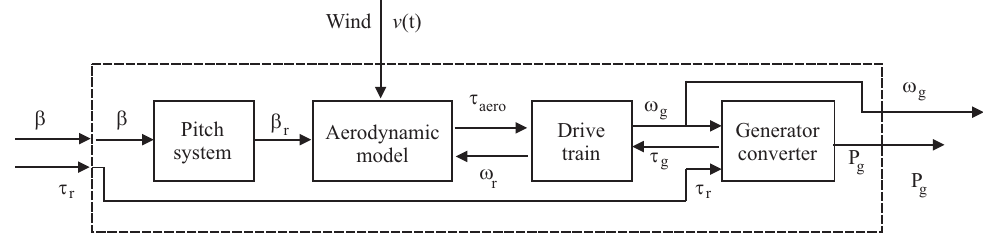
Figure 1. Block diagram of the wind turbine simulator.